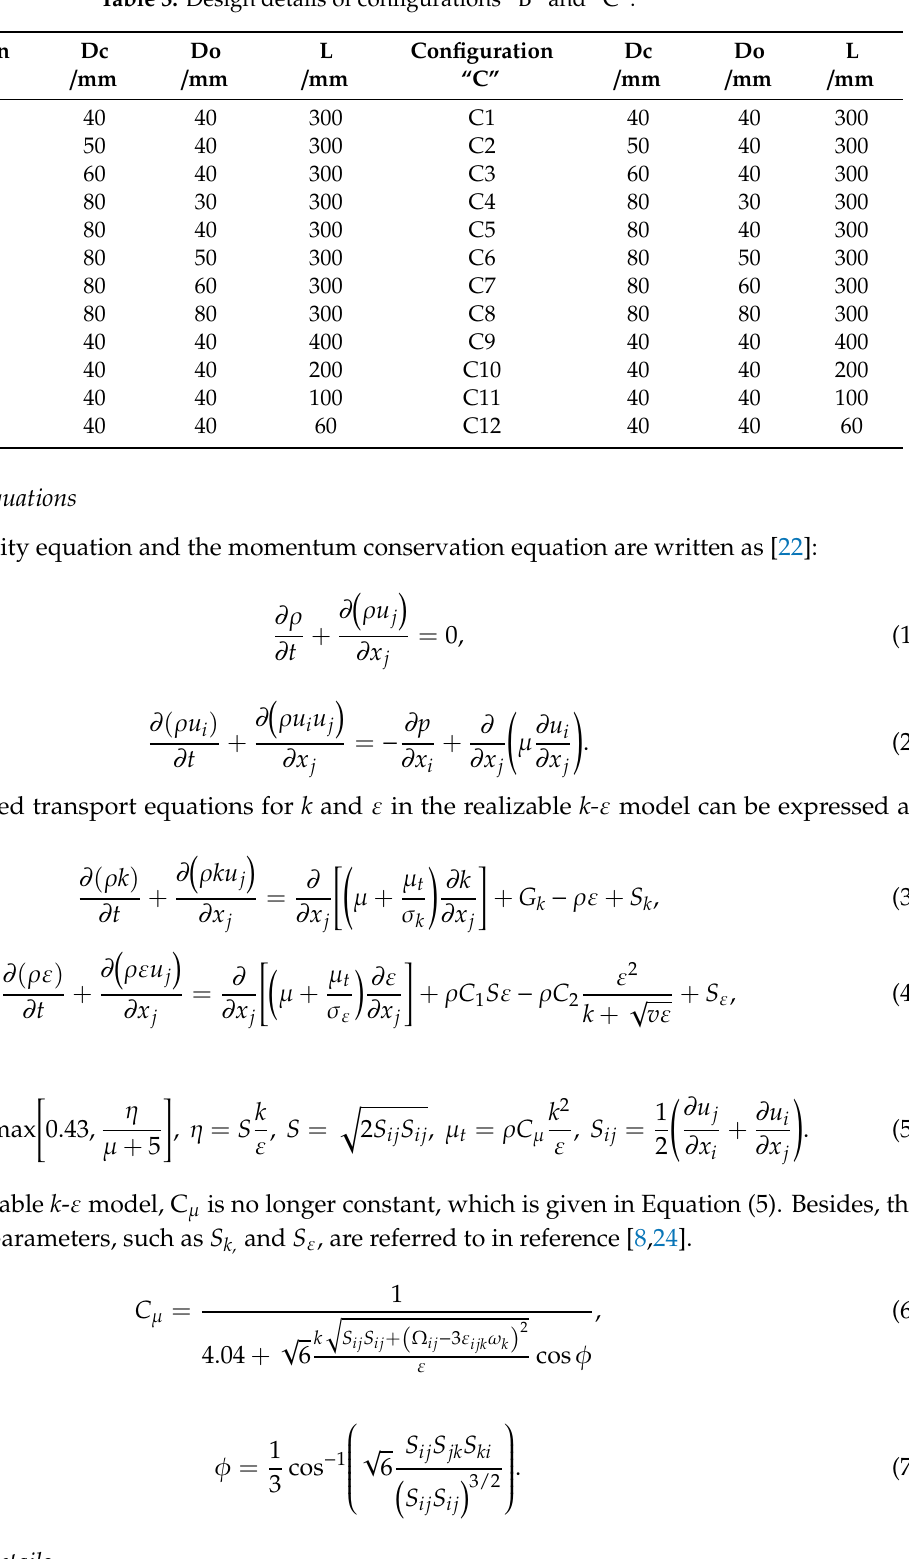
Table 3. Design details of configurations “B” and